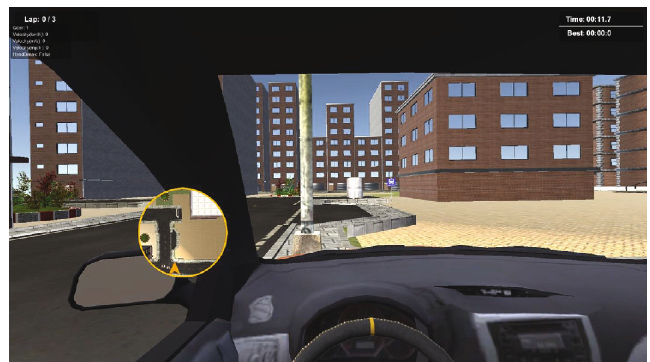
Figure 9: Screenshot of a computer game of time racing.